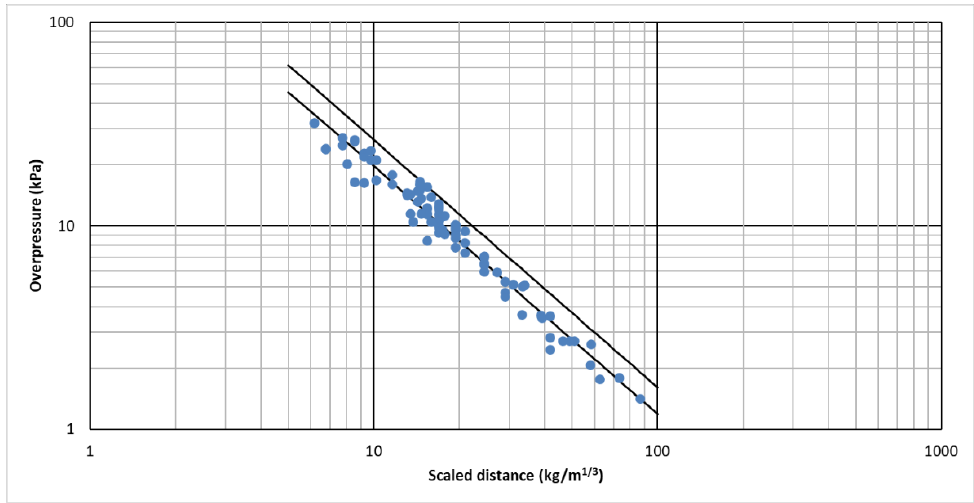
Figure 6. Overpressure measured as a function of scaled distance using the equivalent mass of TNT (dots are actual values while lower and upper lines correspond to Equation 6 and Equation 7).